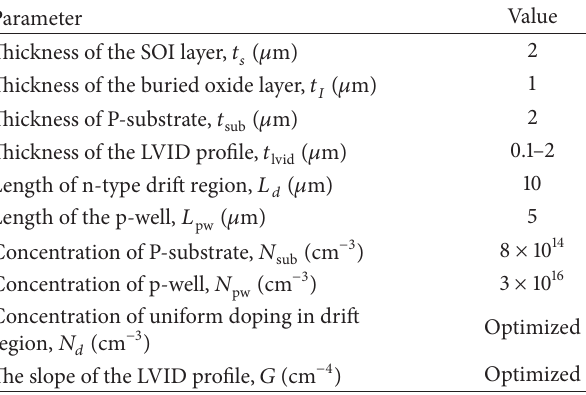
Figure 2: Device mechanism of the LVID SOI LDMOS. Table 1: Device parameters used in the